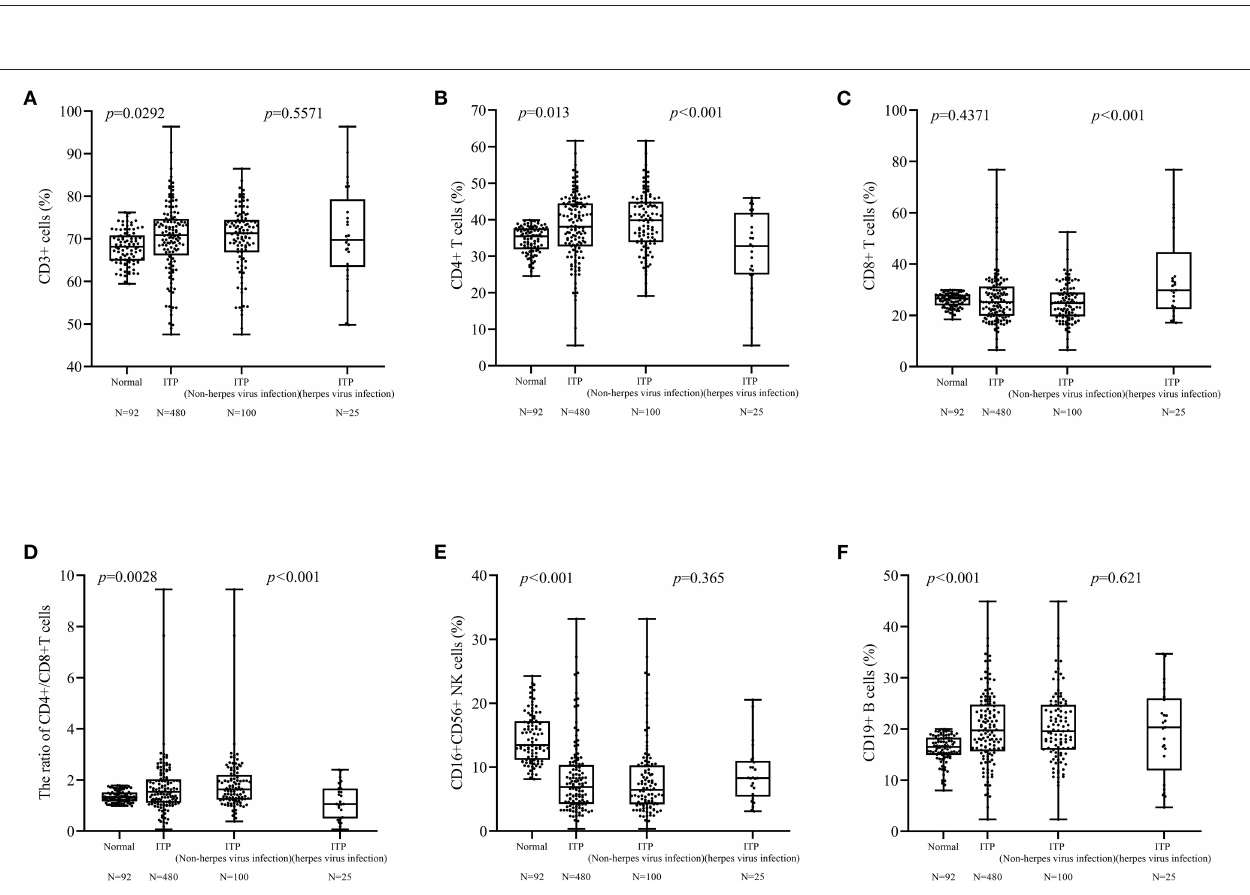
FIGURE 3 | Differences between lymphocyte subsets. (A,E,F) Differences in CD3 + , CD16 + 56 + cells were not found. (B–D) There were differences in the CD4 + cells ( p < 0.001), CD8 + cells ( p < 0.001), and CD4 + /CD8 + cells ratio ( p < 0.001) cells between patients with and without herpes virus infection.